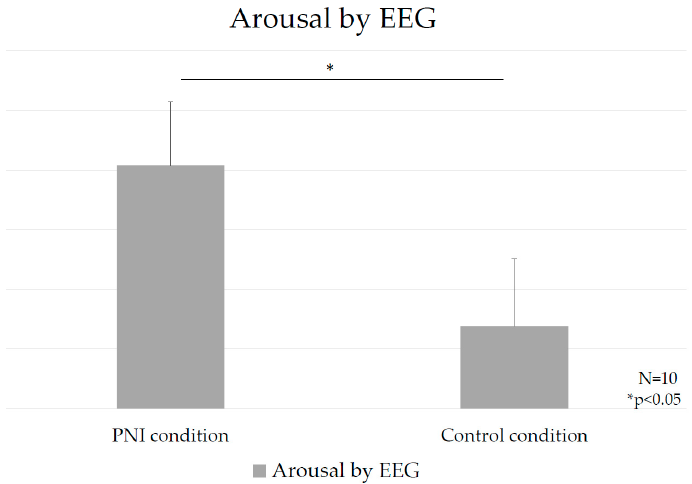
Figure 5. Comparing the amount of change in arousal by electroencephalogram (EEG) in PNI and control conditions.